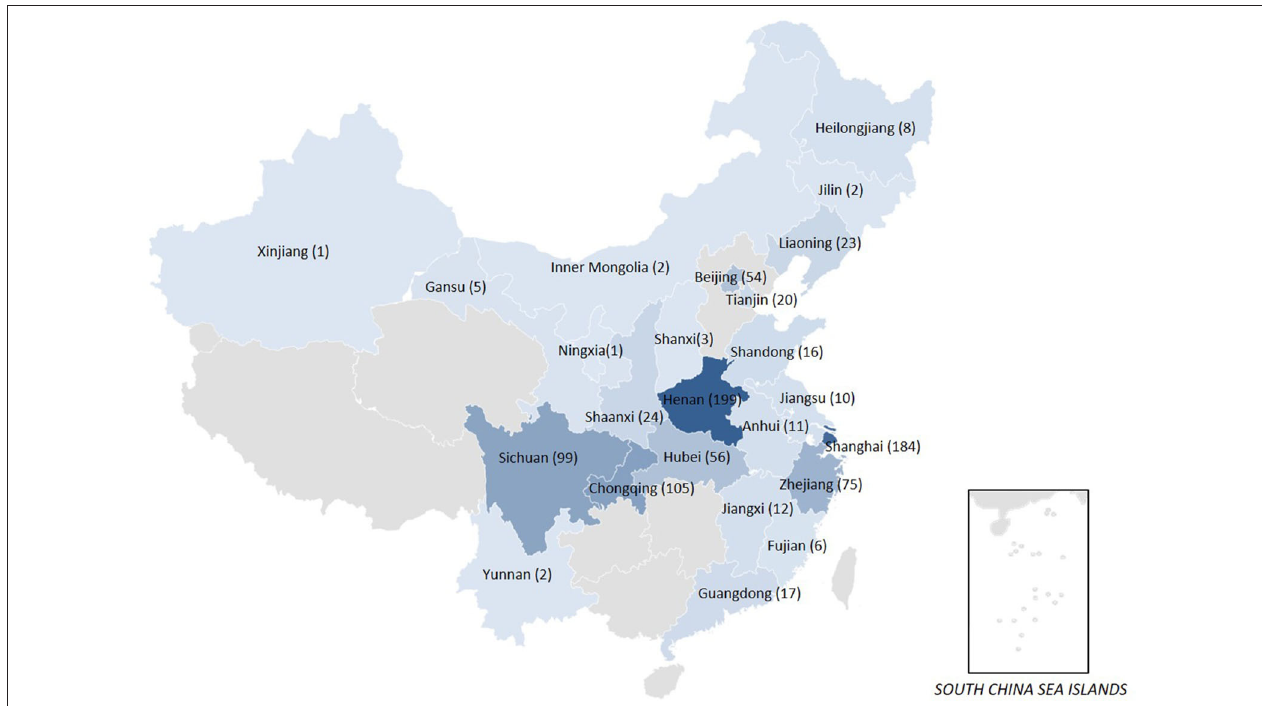
FIGURE 1 | The map of CRE clinical strains collected from 24 provinces or cities in